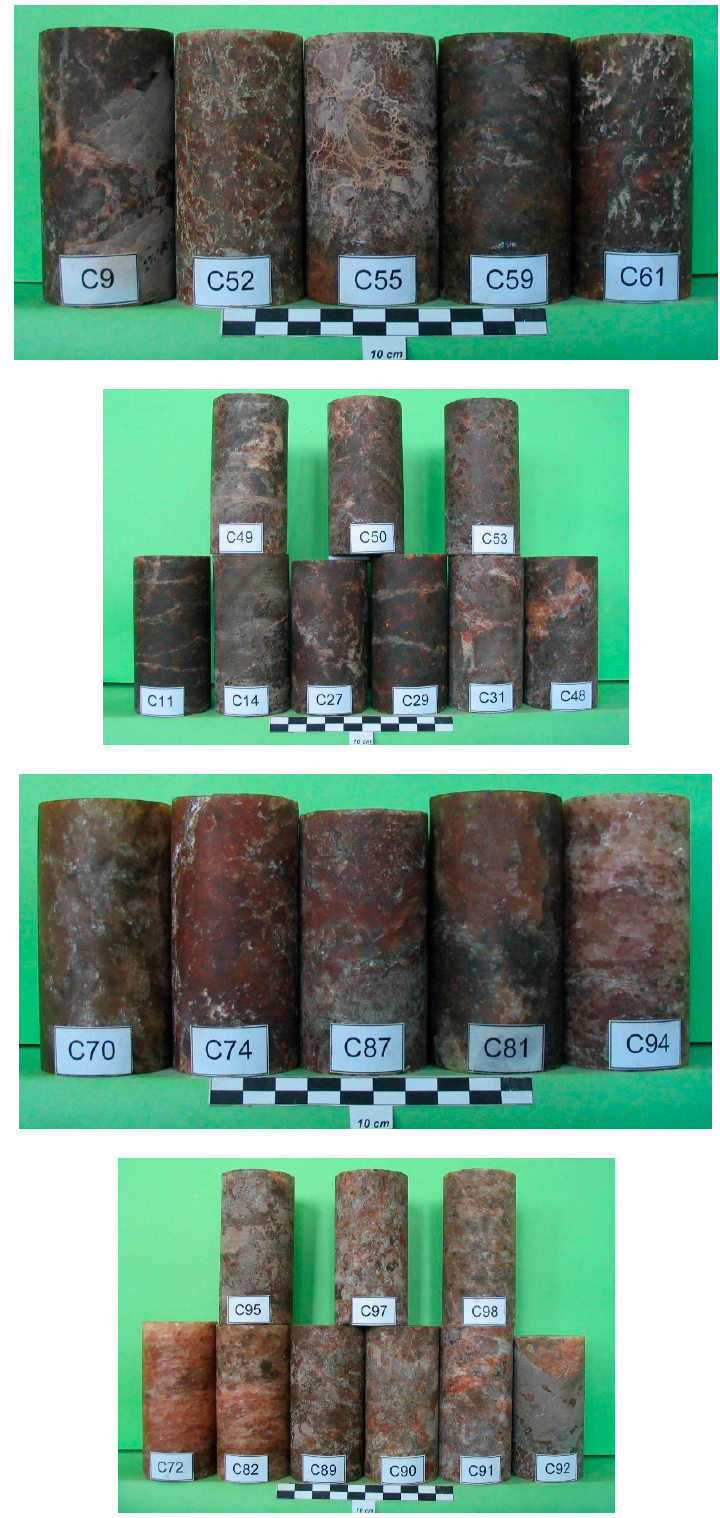
Figure A2. The Red Zuber unit samples for short-term compression tests at a constant stress rate and for rheological tests.